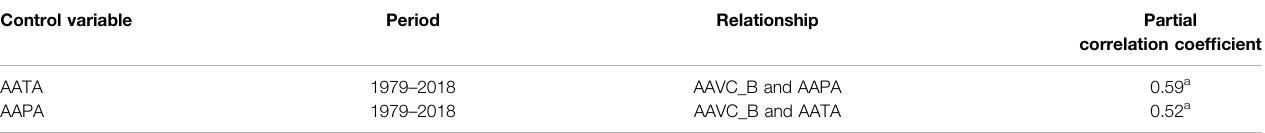
TABLE 5 | Relationship between lake volume changes and climate factors. Partial correlation coef fi cient of AAVC_B and AAPA when the control variable is AATA; Partial correlation coef fi cient of AAVC_B and AATA when the control variable is AAPA.